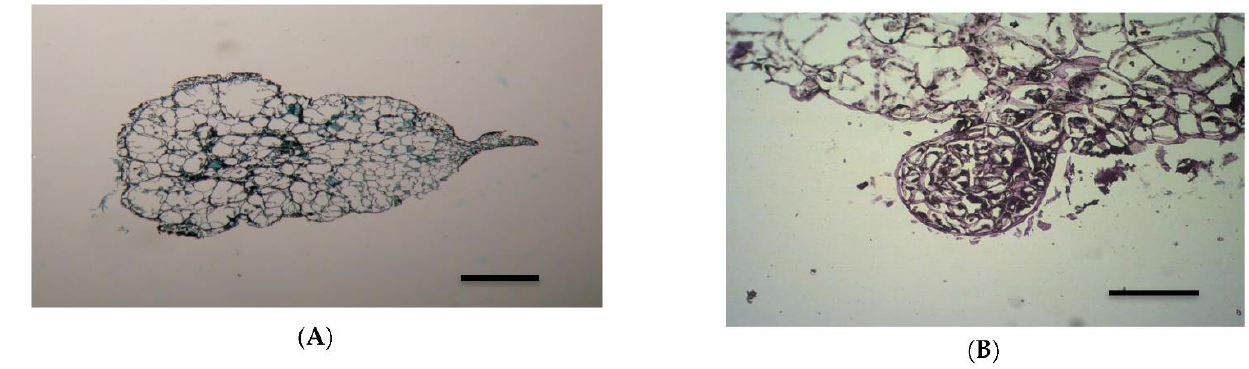
Figure 5. tTCL sections of Phalaenopsis hybrid protocorm showing PLB formation. ( A ) Initial section of tTCL (bar = 0.1 cm); ( B ) a developing globular-shaped PLB after 2 – 3 weeks of culture (bar = 0.02 mm).